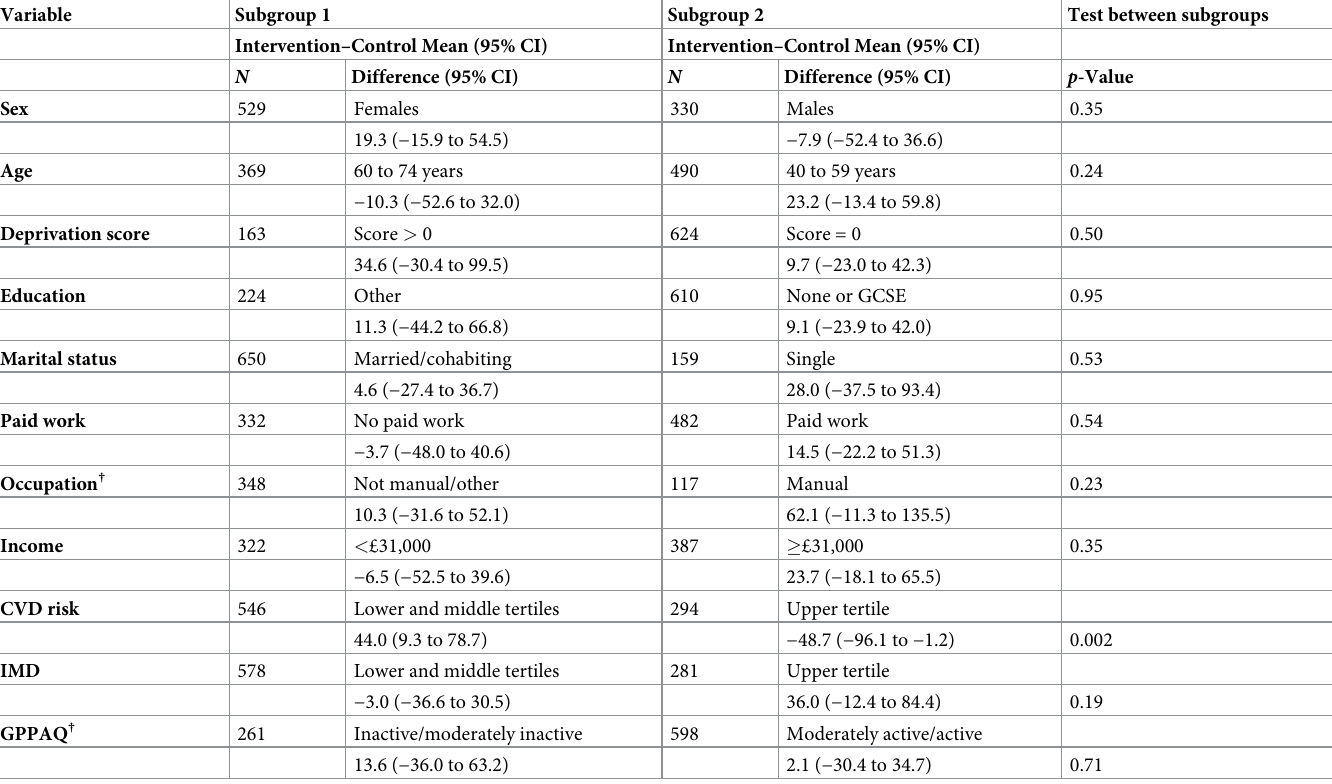
Table 3. Subgroup analyses of primary outcome.